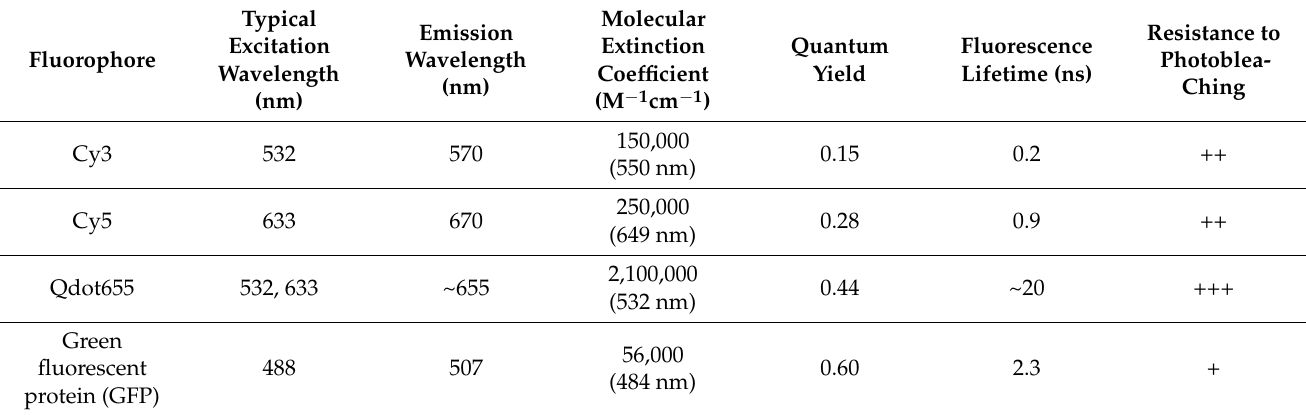
The markings +, ++, and +++ indicate “poor,” “moderate,” and “excellent,” respectively. Adapted with permission from [7].